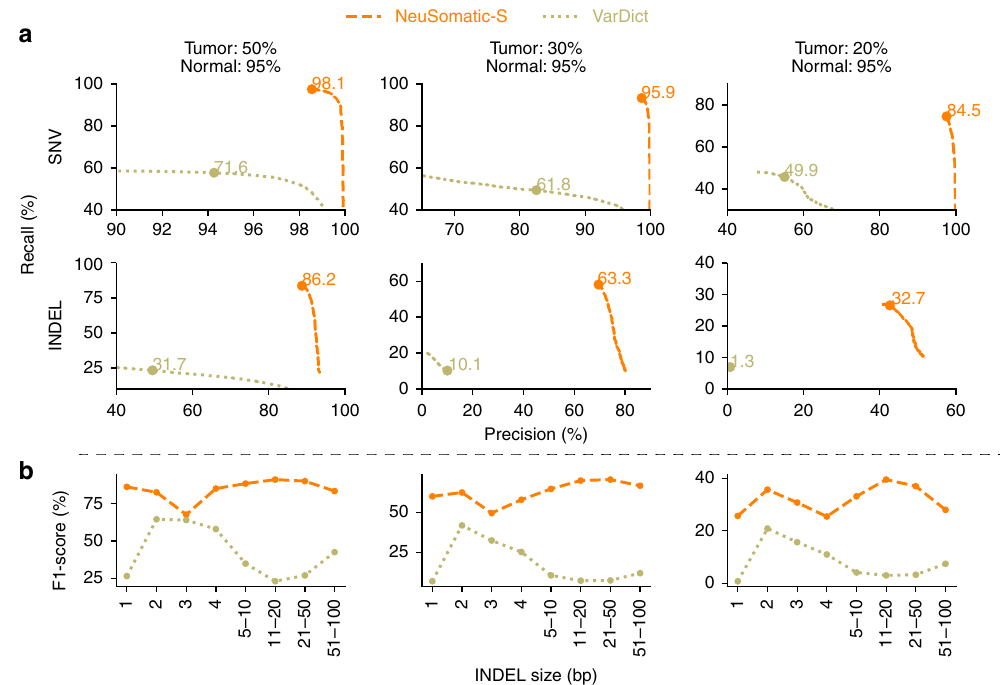
Fig. 5 Performance analysis of the PacBio dataset. In this dataset, three tumor and normal purity scenarios (70% T:95% N, 50% T:95% N, and 25% T:95% N) are used. a Precision-recall analysis: the con fi dence or quality scores are used to derive the precision-recall curves. The highest F1-score achieved by each algorithm is printed on the curve and marked with a solid circle. b Performance analysis of INDEL accuracy (F1-score) for different INDEL